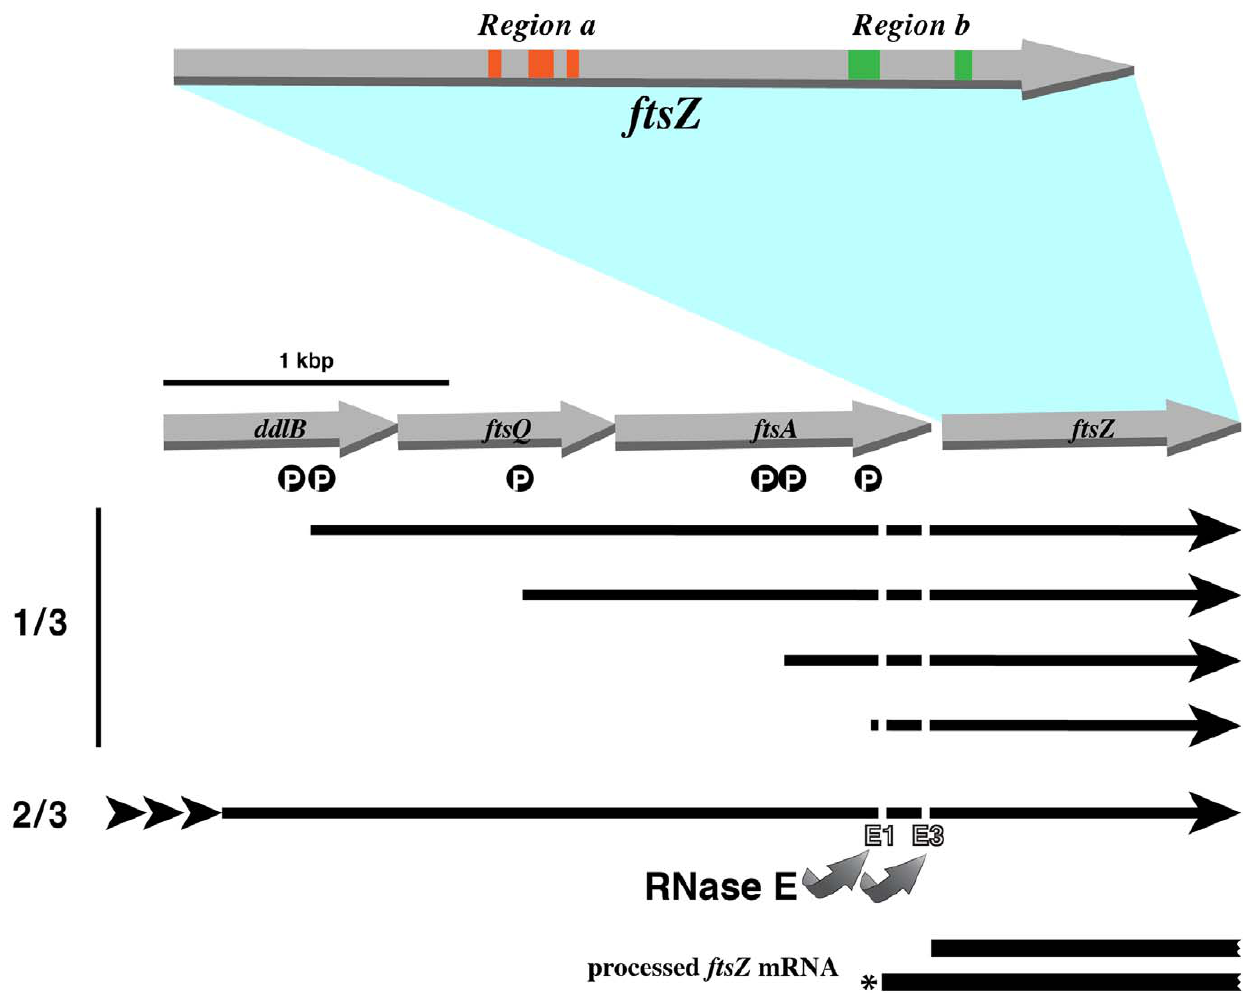
Figure 1. Genetic organization of the relevant region of the dcw cluster. The grey arrows represent genes, the black arrows represent mRNA molecules, and the white P inside a black circle represent locations of the promoters within ddlB, ftsQ , and ftsA . The long mRNAs originated at promoters upstream of ddlB are represented by a black arrow with arrowheads at the beginning. The diagram shows that about 1/3 of the transcription of ftsZ originates at the promoters located within ddlB, ftsQ , and ftsA and about 2/3 of the transcription is initiated at the far upstream promoters [38–40]. The E1 and E3 RNase E cleavage sites are indicated by curved arrows. The asterisk shows the RNA molecule utilized in this work to identify EGSs that elicit RNase P-mediated cleavage of the ftsZ mRNA [40]. The regions (‘‘a’’ and ‘‘b’’) used to design EGSs are shown in the same colors used in Figure 2.